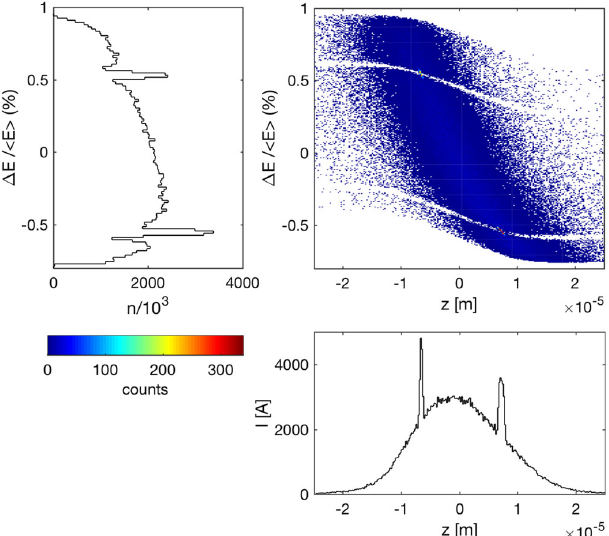
FIG. 6. Power of the emitted radiation as a function of time (top) and corresponding FEL spectra (bottom) to generate two- color FEL pulses with two different pulse durations (see text for more